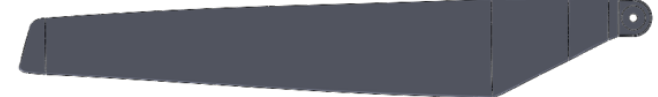
Figure 13. Final parametric model of the